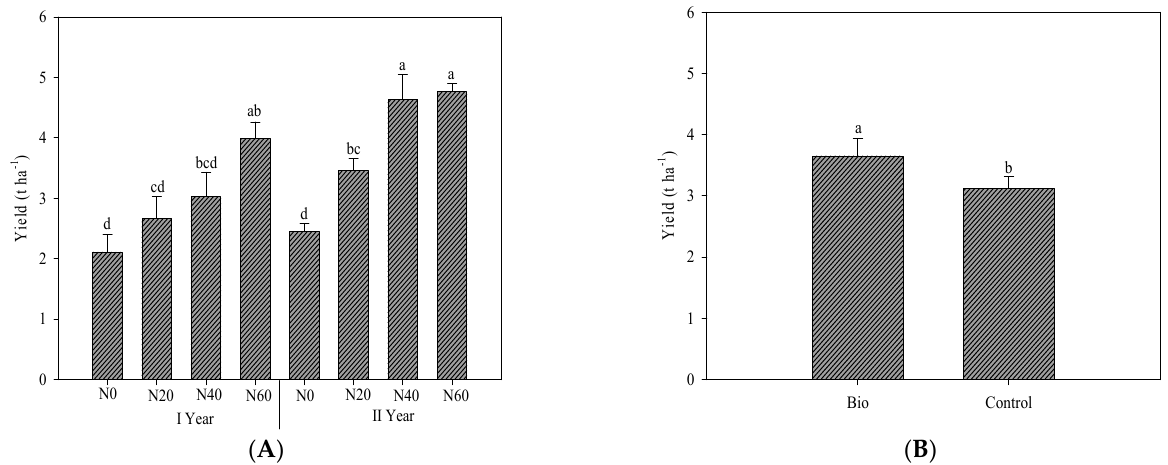
Figure 4. Yield of barley as affected by growing season (2018–2019 = I Year; 2019–2020 = II Year) and nitrogen fertilization levels (not fertilized = N0; fertilized with 20 kg N ha − 1 = N20; fertilized with 40 kg N ha − 1 = N40 and fertilized with 60 kg N ha − 1 = N60)—( A ) and by biostimulant application (treated with biostimulant = Bio and not treated = Control)—( B ). Different letters indicate significant differences according to Duncan’s test ( p < 0.05).